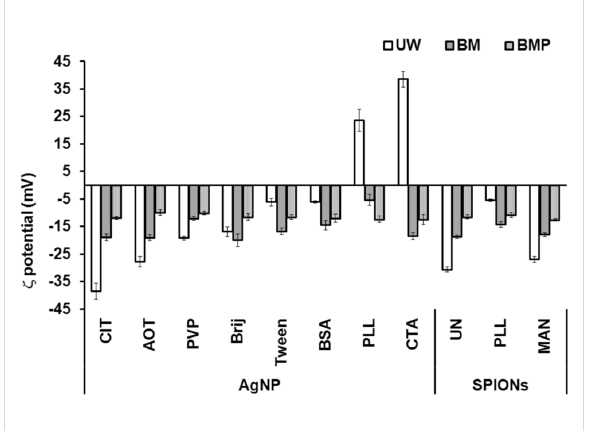
Figure 4: Zeta-potential ( ζ ) values of differently coated silver (AgNPs) and superparamagnetic iron oxide nanoparticles (SPIONs) in ultra- pure water (UW), biological medium (BM) and biological medium supplemented with 0.1% bovine serum albumin (BMP) after 1 h at 25 °C. Coating agents: trisodium citrate (CIT), sodium bis(2-ethylhexyl) sulfosuccinate (AOT), poly(vinylpyrrolidone) (PVP), Brij 35 (Brij), Tween 20 (Tween), bovine serum albumin (BSA), poly(L-lysine) (PLL), cetyltrimethylammonium bromide (CTA) and D-mannose